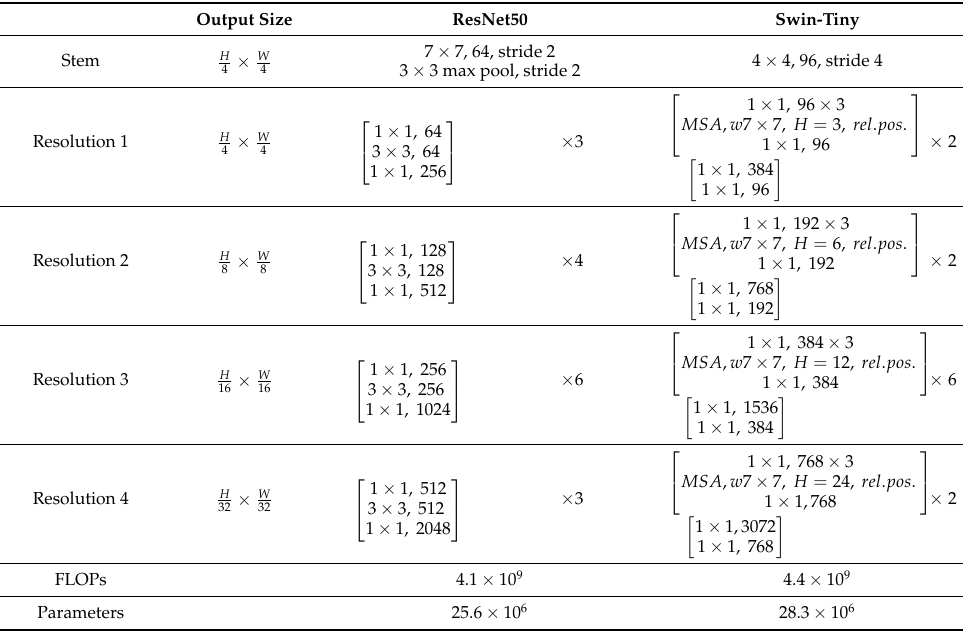
Figure 4. Basic block designs for ResNet, HRNet, and Swin. Table 2. Detailed architecture specifications of ResNet50 and Swin-tiny, where the bracket indicates a residual block, and the number outside the brackets is the number of stacked blocks for the